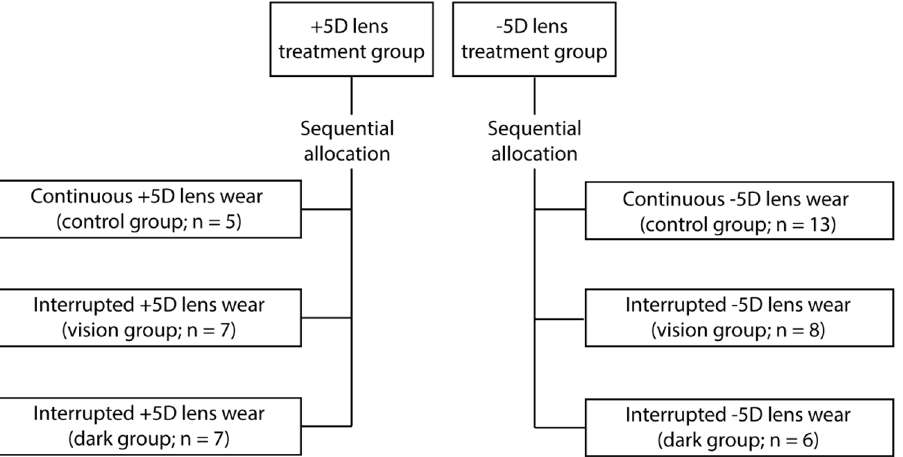
Figure 1. Sequential allocation of marmosets in the control and treatment groups for both + 5D and − 5D lens wear. Note that the sample size of the − 5D lens wear control group is larger compared to other groups as it included historical